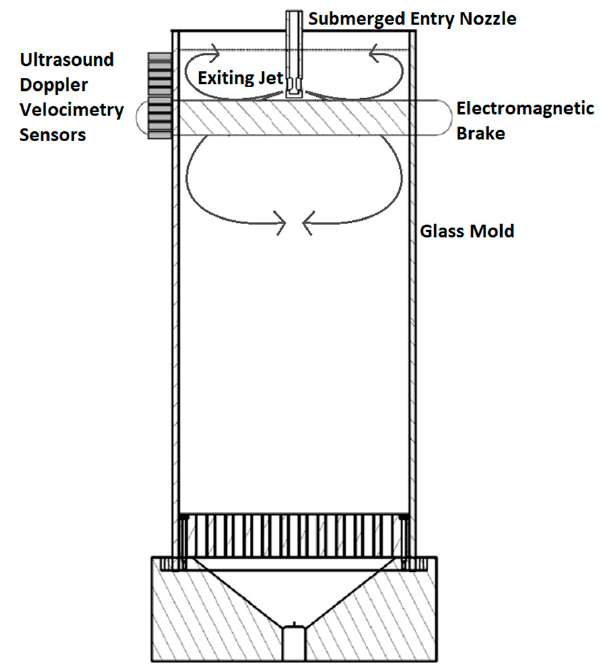
Figure 4. Schematic of mold illustrating the position of the sensors and electromagnetic brake. Table 1. Physical properties of gallium-indium-tin [17].